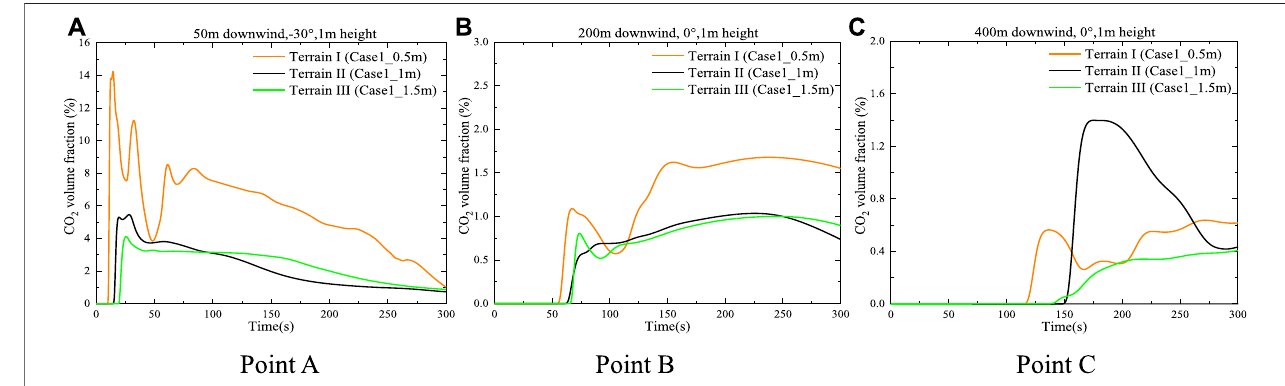
FIGURE 10 | Contours of the turbulent kinetic energy at three different